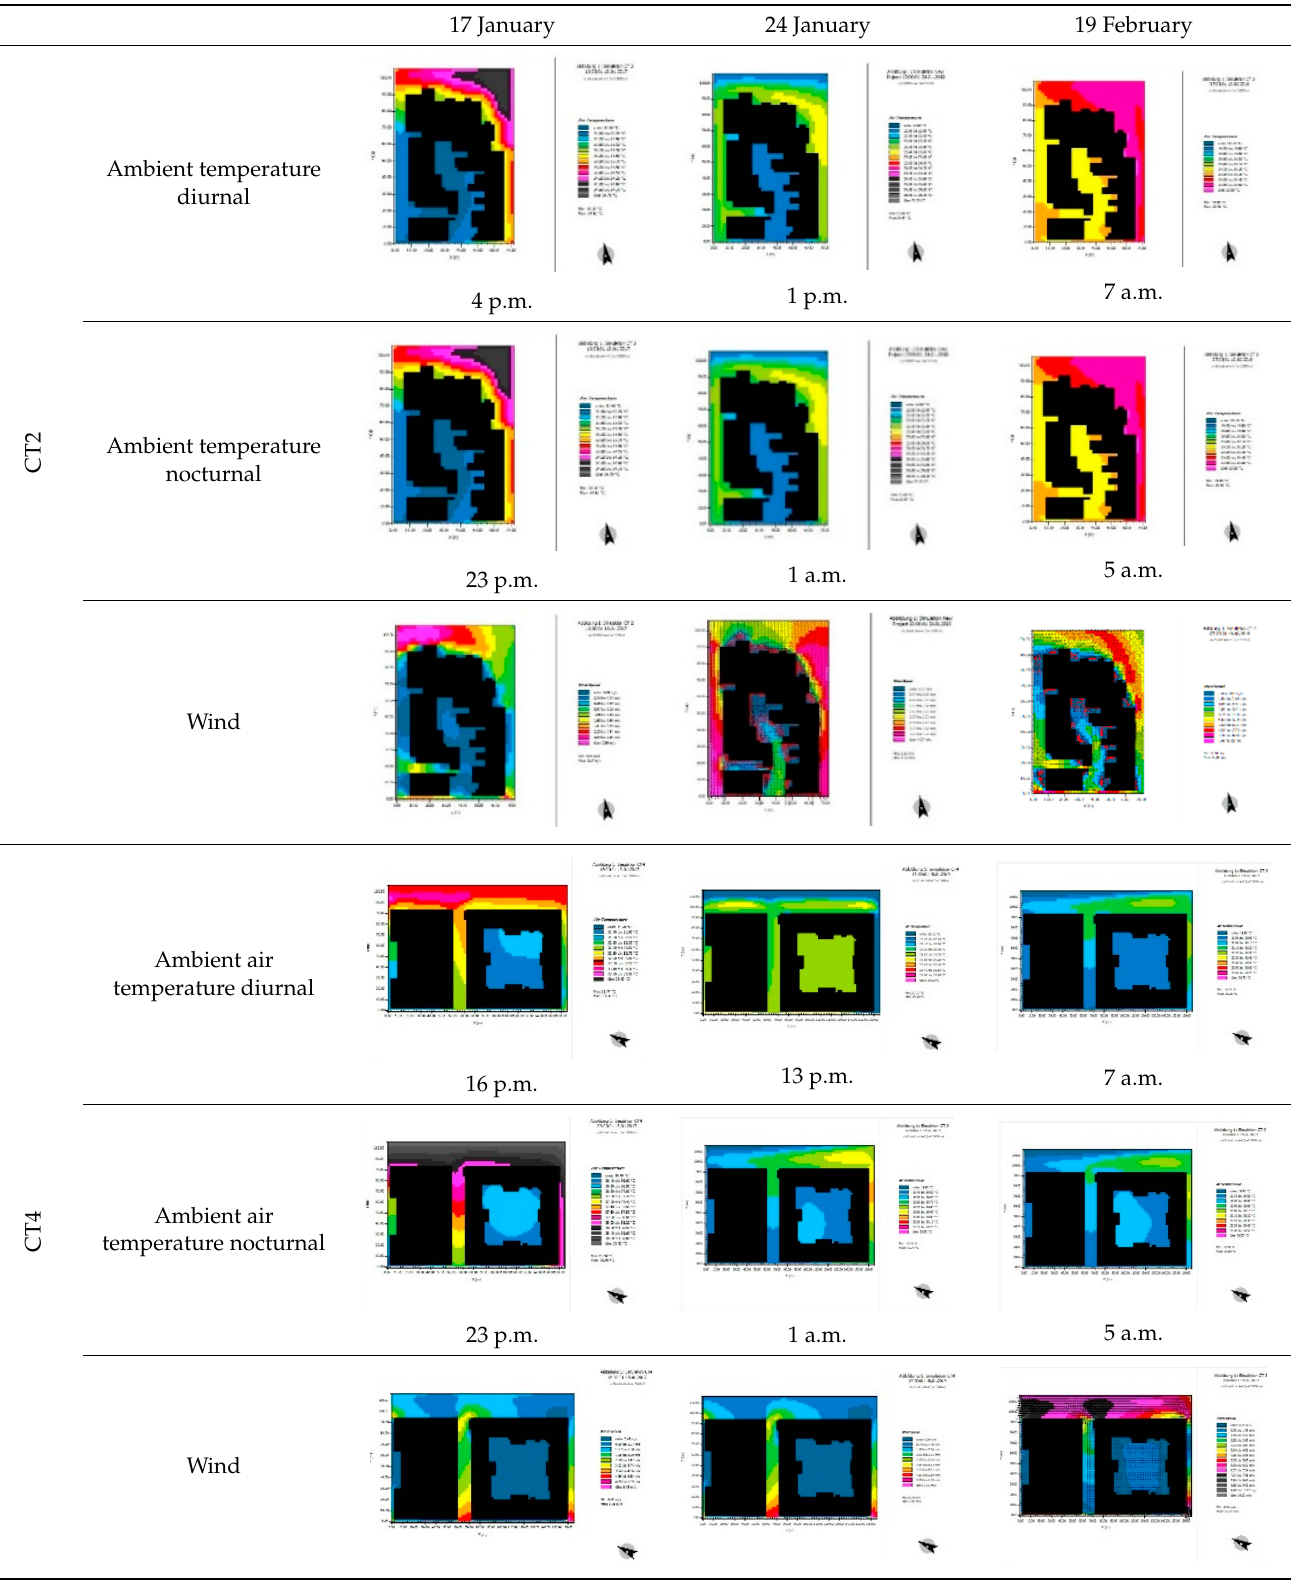
Table A3. Summary of heat island effect in compact type series.